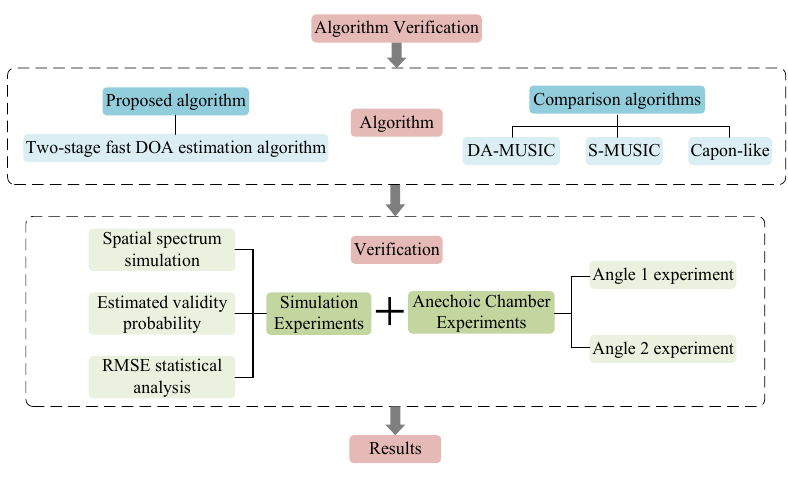
Figure 3. Algorithm verification flowchart.